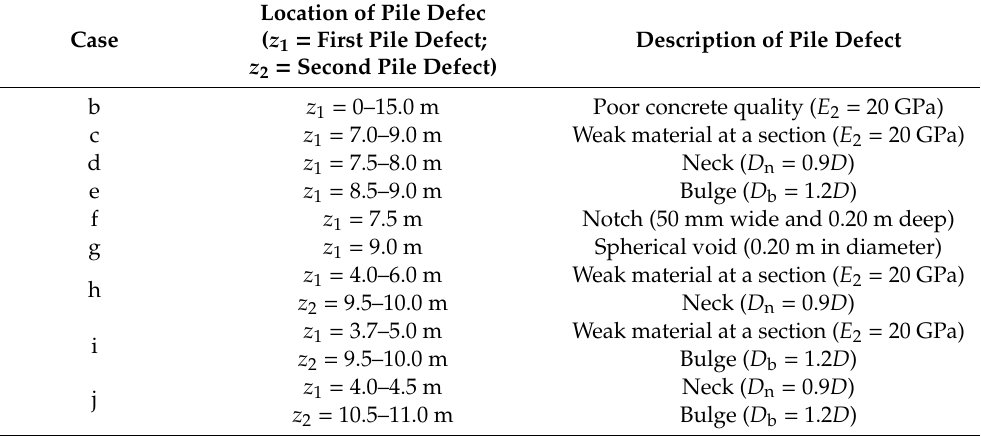
Table 3. Properties of defective piles in Figure 8 that were used to simulate the impact echo test by